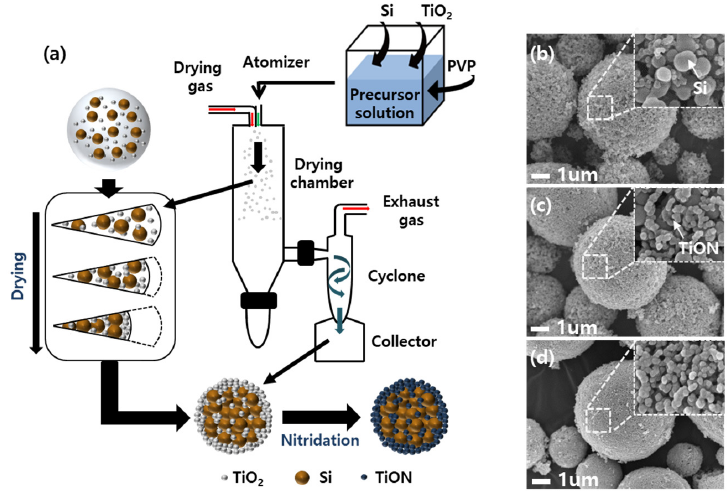
Figure 2. ( a ) Graphical illustration for synthesis of Si-TiON composite using spray-drying and subsequent nitridation. FE-SEM images of Si-TiON composite synthesized using different molar ratios of Si and TiON: ( b ) 1:0.5 ( c ) 1:1 ( d ) 1:2. Inset represents high-resolution